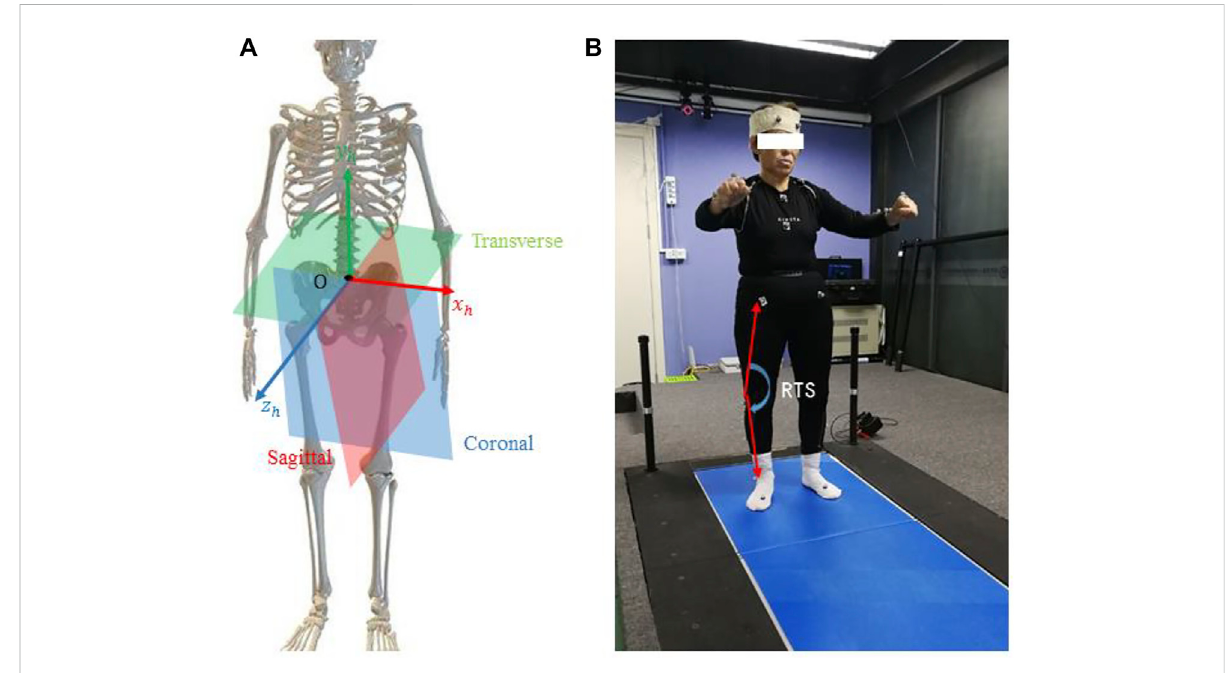
FIGURE 4 Illustration of the human body coordinate system (A) and extracted joint angle features for the subject (B)